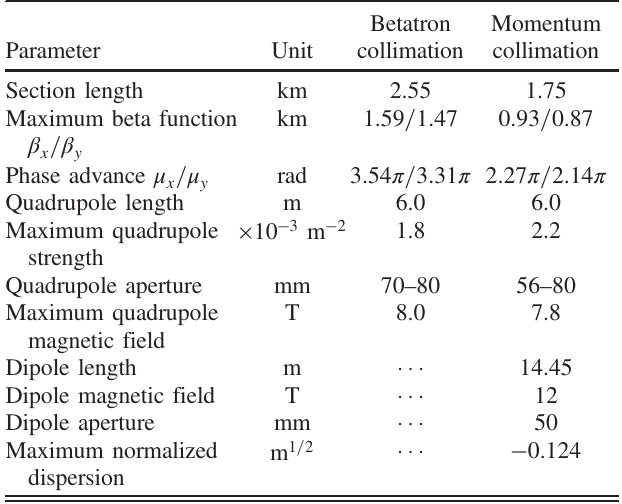
TABLE II. Basic parameters of the collimation insertion in lattice scheme II.